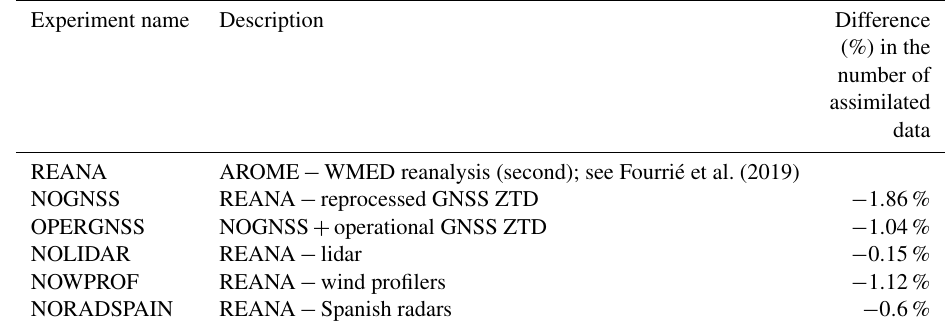
Table 2. Description of the data denial experiments discussed in this study and difference (in %) in the amount of assimilated data compared to the reanalysis REANA.